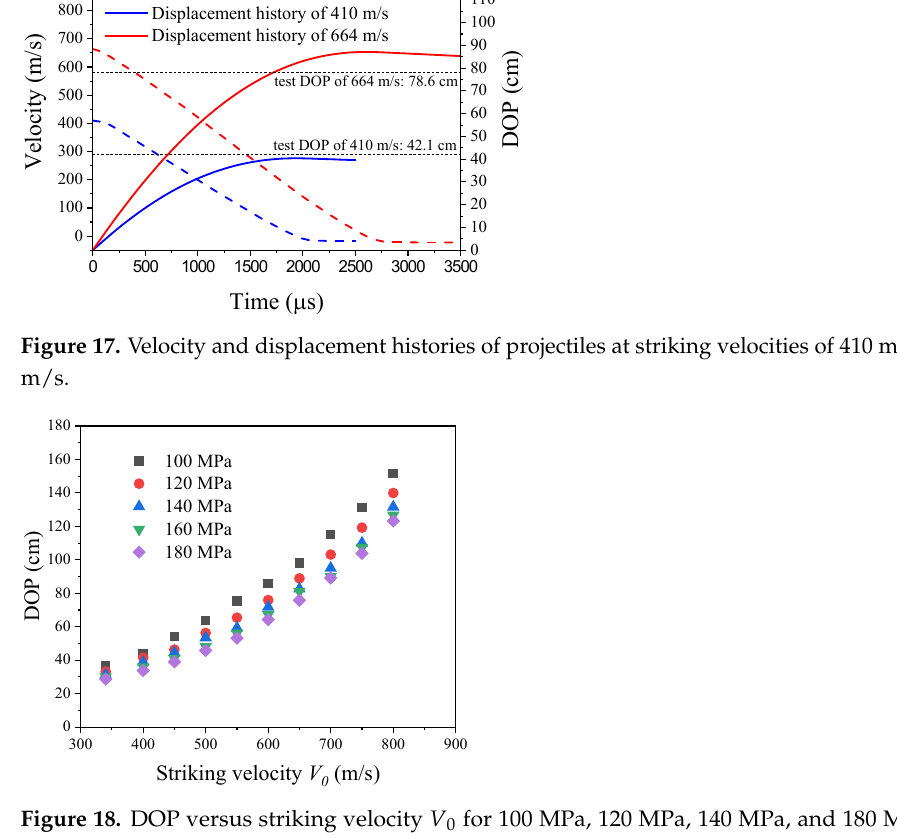
Figure 18. DOP versus striking velocity V 0 for 100 MPa, 120 MPa, 140 MPa, and 180 MPa UHPC targets, where the volume content of the steel fiber is 2% .